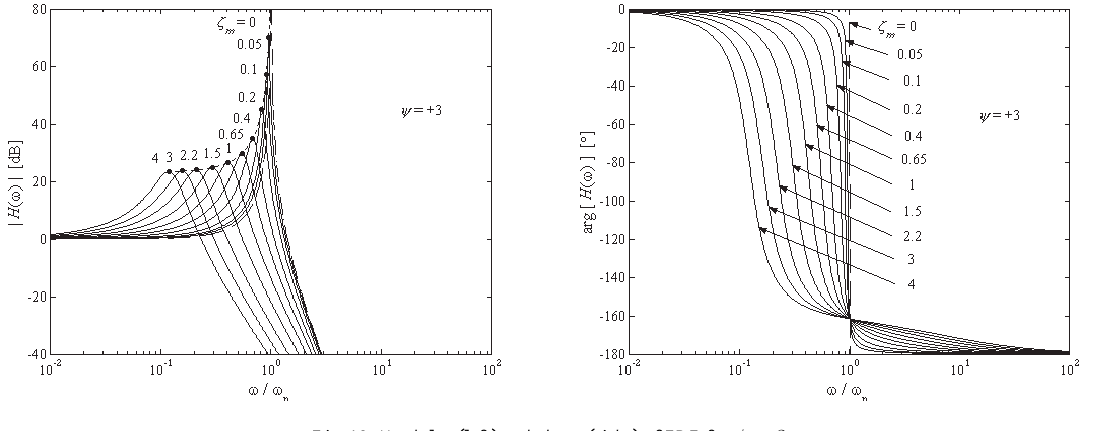
Fig. 13. Modulus (left) and phase (right) of FRF for ψ = 3